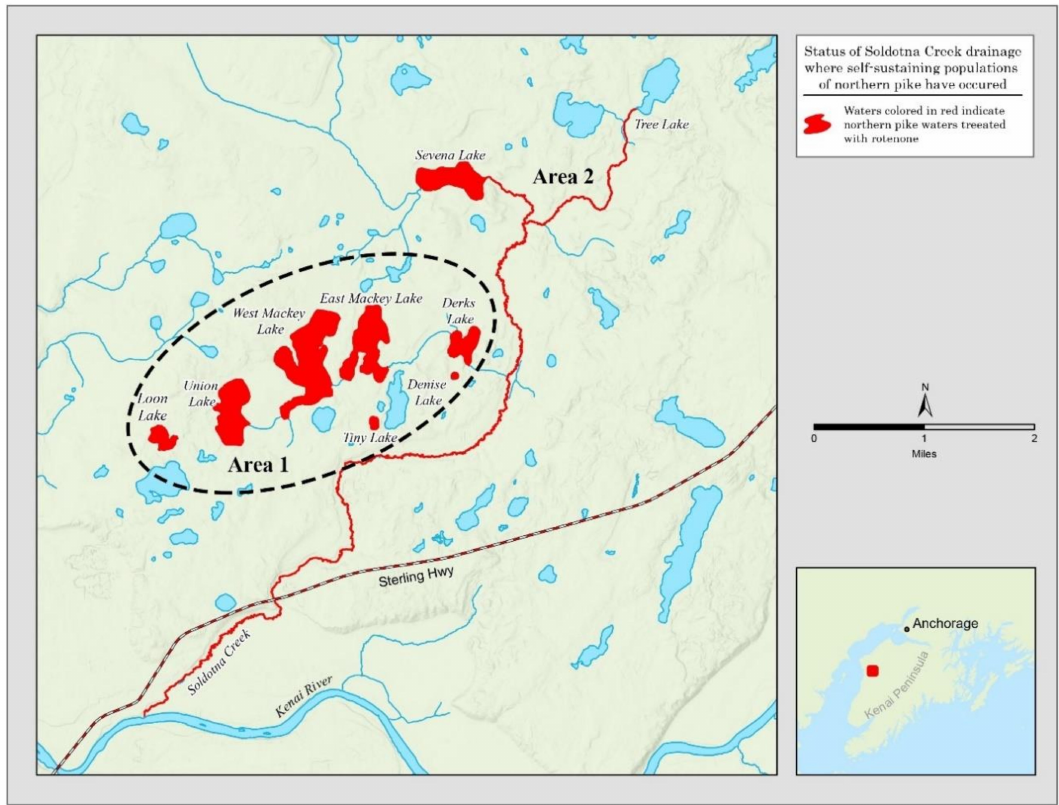
Figure 9. Map of the Soldotna Creek project area for the largest pike eradication project in SC Alaska. This eradication e ff ort was completed between 2014 and 2018. Temporary barriers were installed to separate Area 1 (encircled) from Area 2 (Sevena Lake and Soldotna Creek). The lakes in Area 1 were treated in 2014 (Loon Lake was treated in 2017). During 2015, native fish from Area 2 were rescued and replanted in Area 1. Area 2 was treated in 2016 and 2017, and the barriers were removed to allow fish movement throughout the